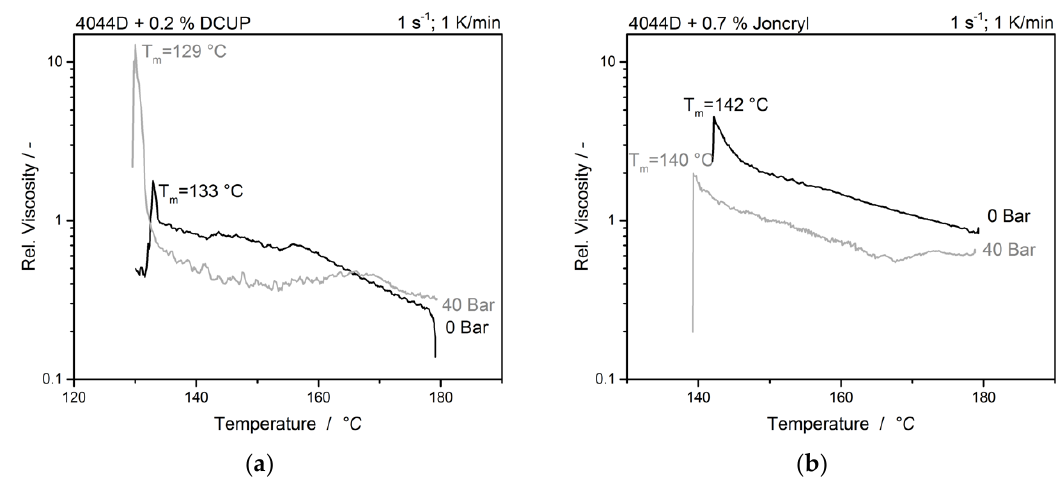
Figure 8. Crystallization of the ( a ) DCUP and ( b ) Joncryl modified samples at two different pressures.